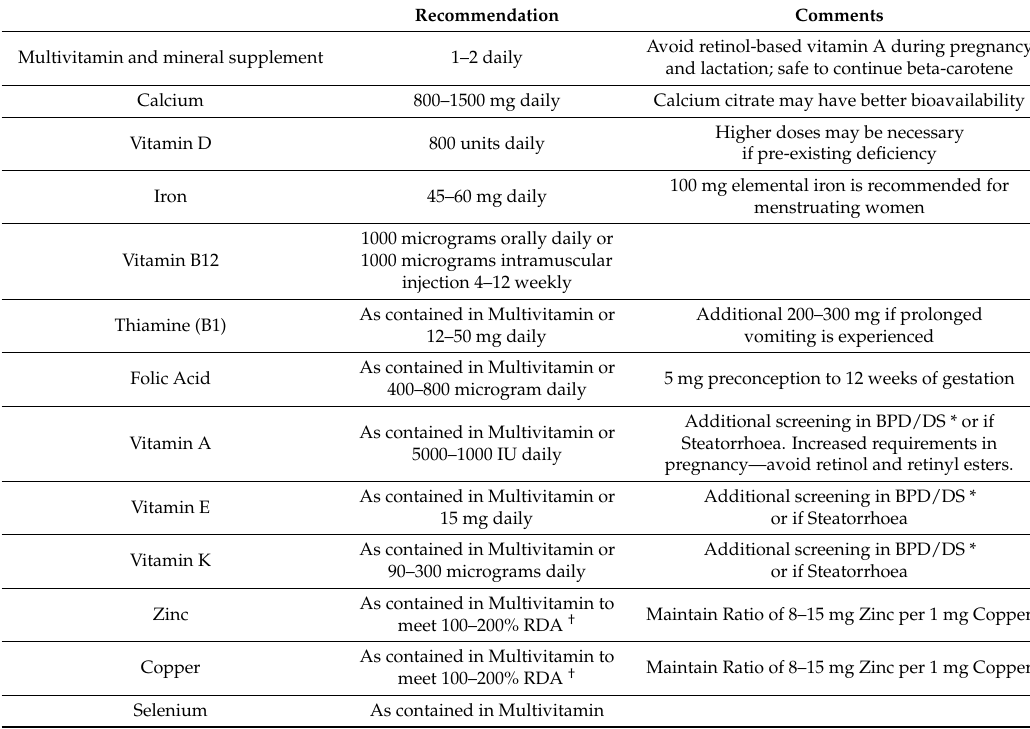
Table 1. Summary of global recommendations for supplements post-bariatric